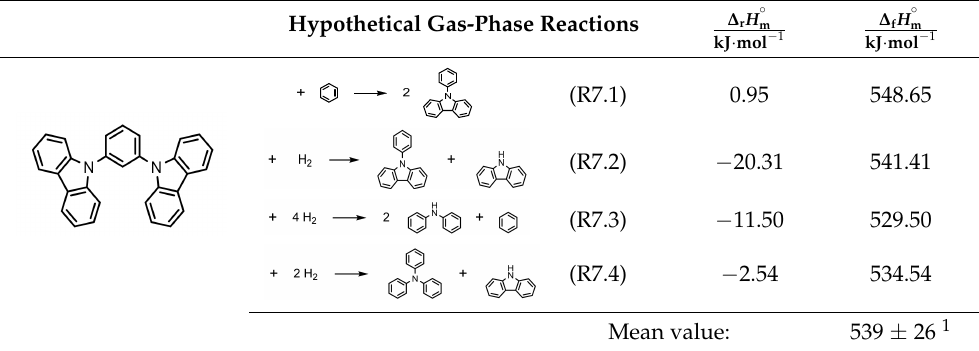
Table 7. Hypothetical gas-phase reactions and corresponding enthalpies of reactions, ∆ r H ◦ m (g), together with the calculated gas-phase enthalpy of formation, ∆ f H ◦ m ( g ) , of NCB, at T = 298.15 K.